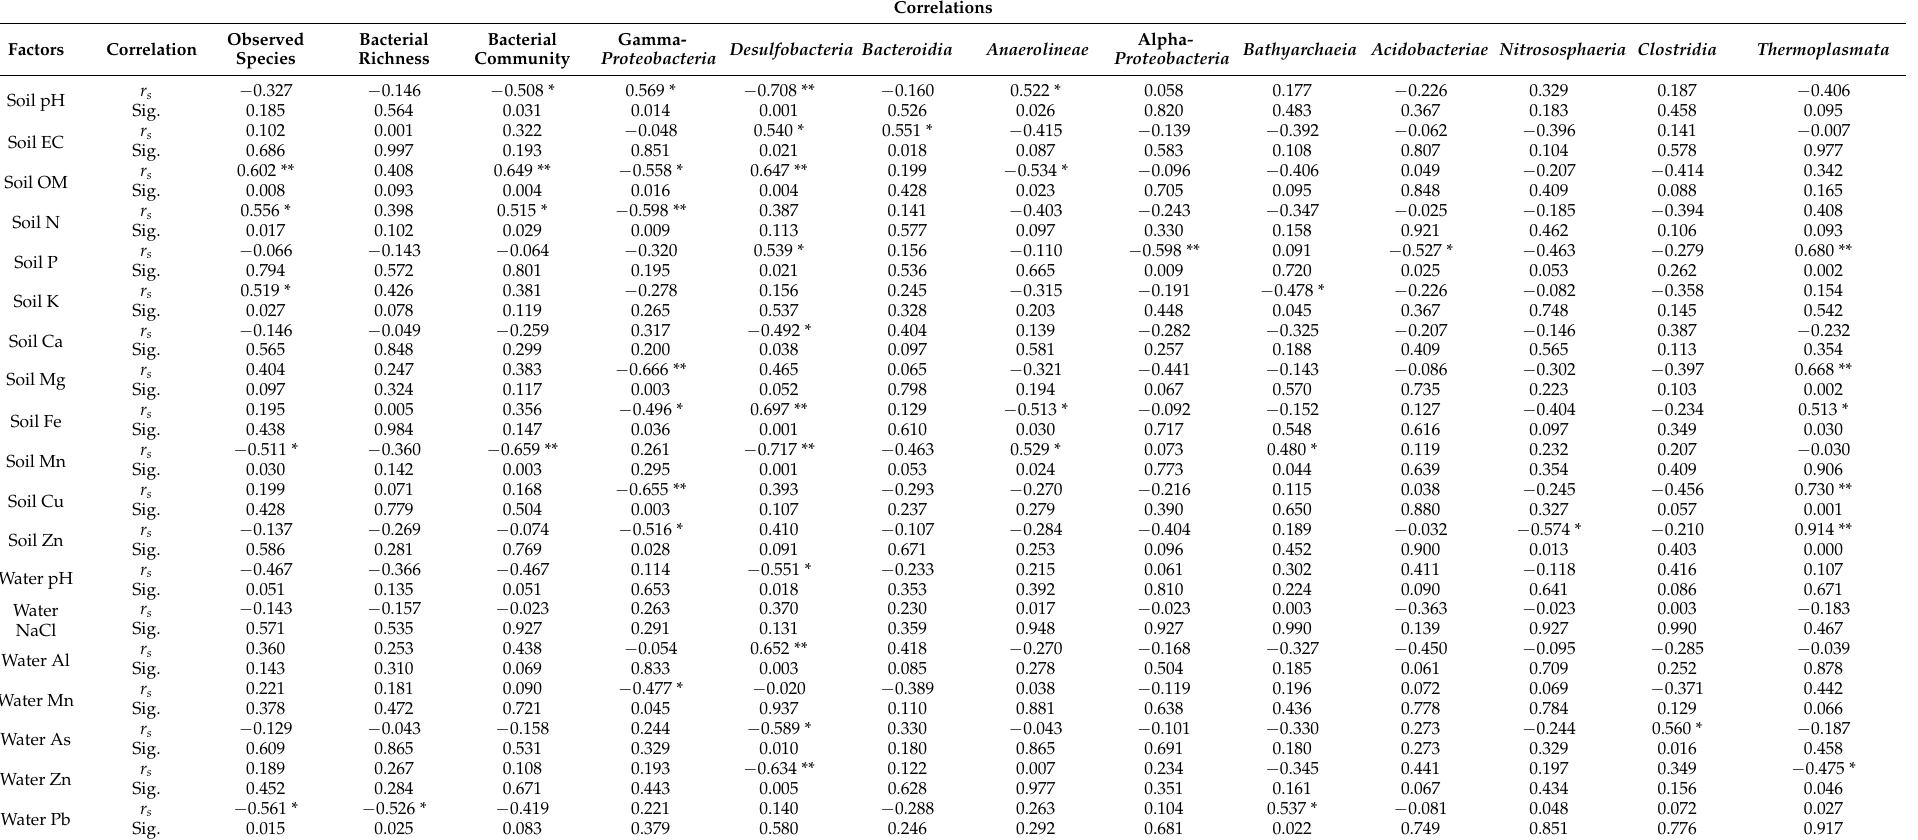
Table 5. Spearman’s ( r s ) correlations between abiotic and biotic factors of each sampling